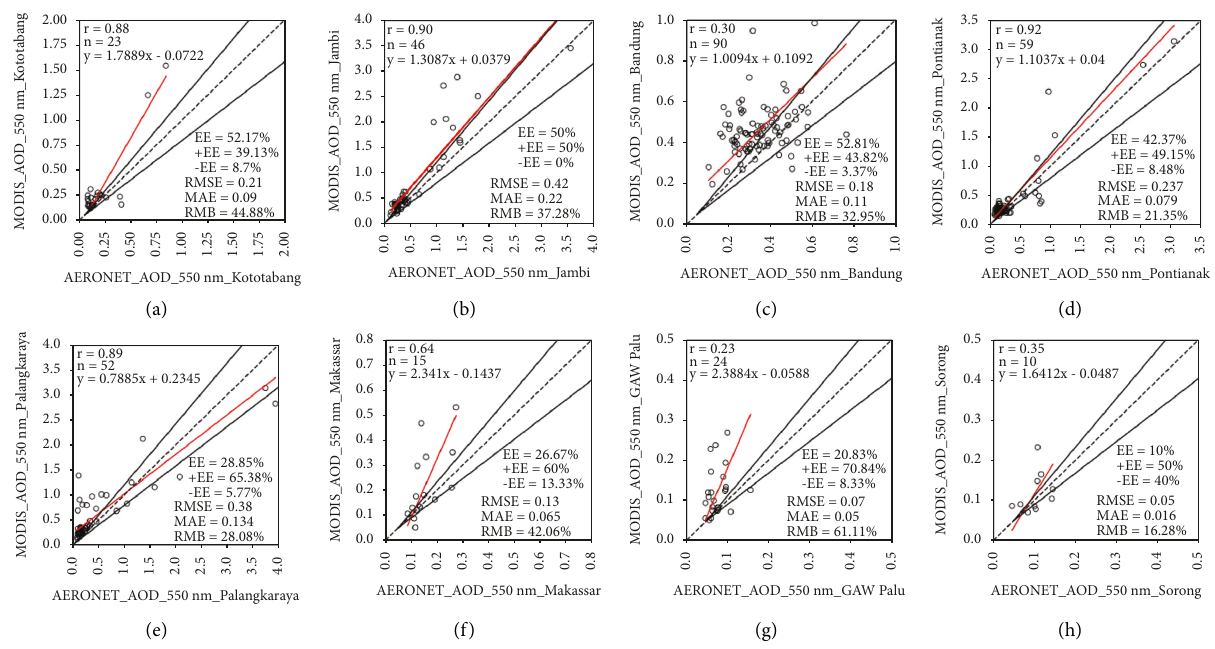
Figure 2: Density scatterplot of monthly MODIS DB AOD 550nm retrievals against AERONET AOD measurements at 550nm at AERONETsites over Indonesia, which include Kototabang (a), Jambi (b), Bandung (c), Pontianak (d), Palangkaraya (e), Makassar (f), GAW Palu (g), and Sorong (h). The solid lines are the envelopes of the expected error (EE), while the black dashed line is the 1:1 line, and the dashed black lines represent the upper and lower EE envelope. +EE indicates the overestimated tendency, while − EE indicates the underestimated